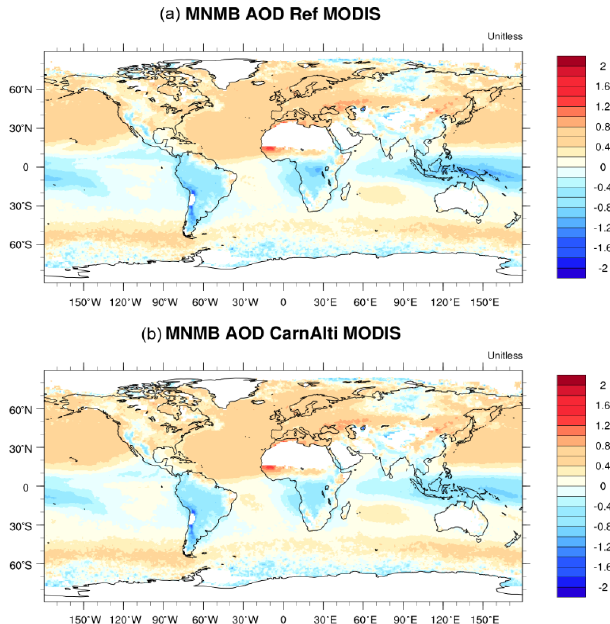
Figure 5. Maps of the 2013 annual MNMB of aerosol opti- cal depth against MODIS monthly observations for (a) REF and (b) CARNALTI